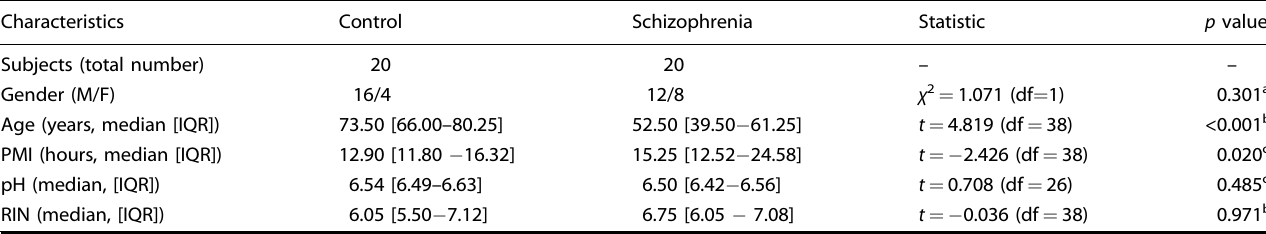
Table 1. Demographic and clinical characteristics of control subjects and schizophrenia